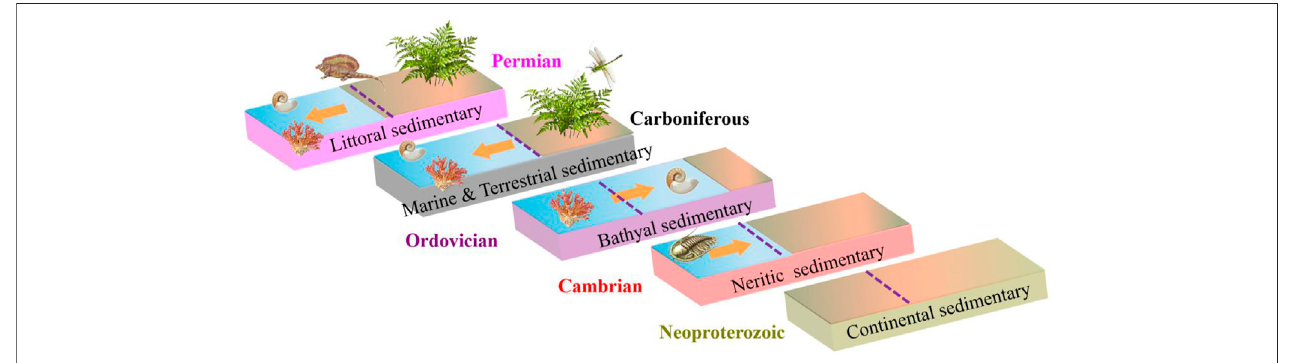
FIGURE 6 | Schematic diagrams of the geological evolution of the Liujiang